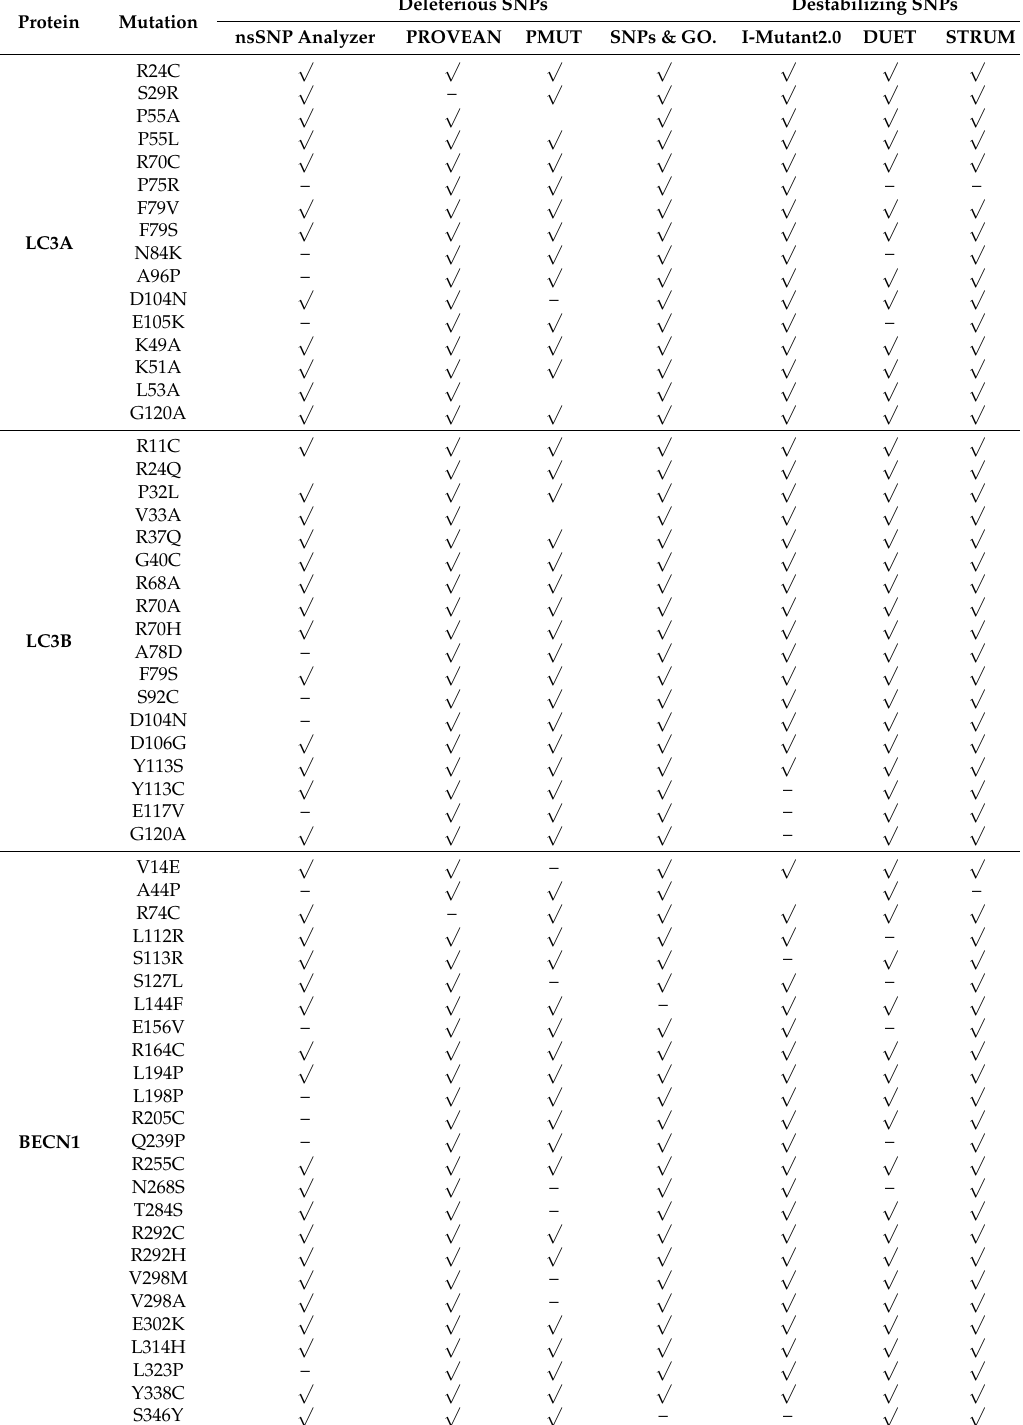
Table 1. Missense SNPs in LC3A, LC3B, BECN1 and SCD1 predicted to be deleterious using nsSNP Analyzer, PROVEAN, PMUT and SNPs & GO. I-Mutant2.0, DUET and STRUM web servers were used for stability